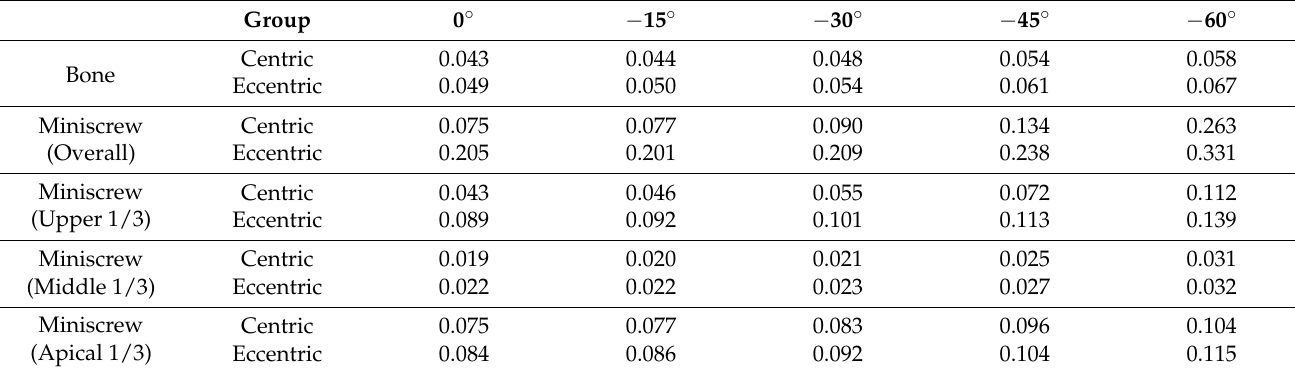
Table 3. Maximum Von-Mises stress (GPa) at the bone and each part of the orthodontic miniscrew according to the position of the hole in the head part and the negative wire insertion